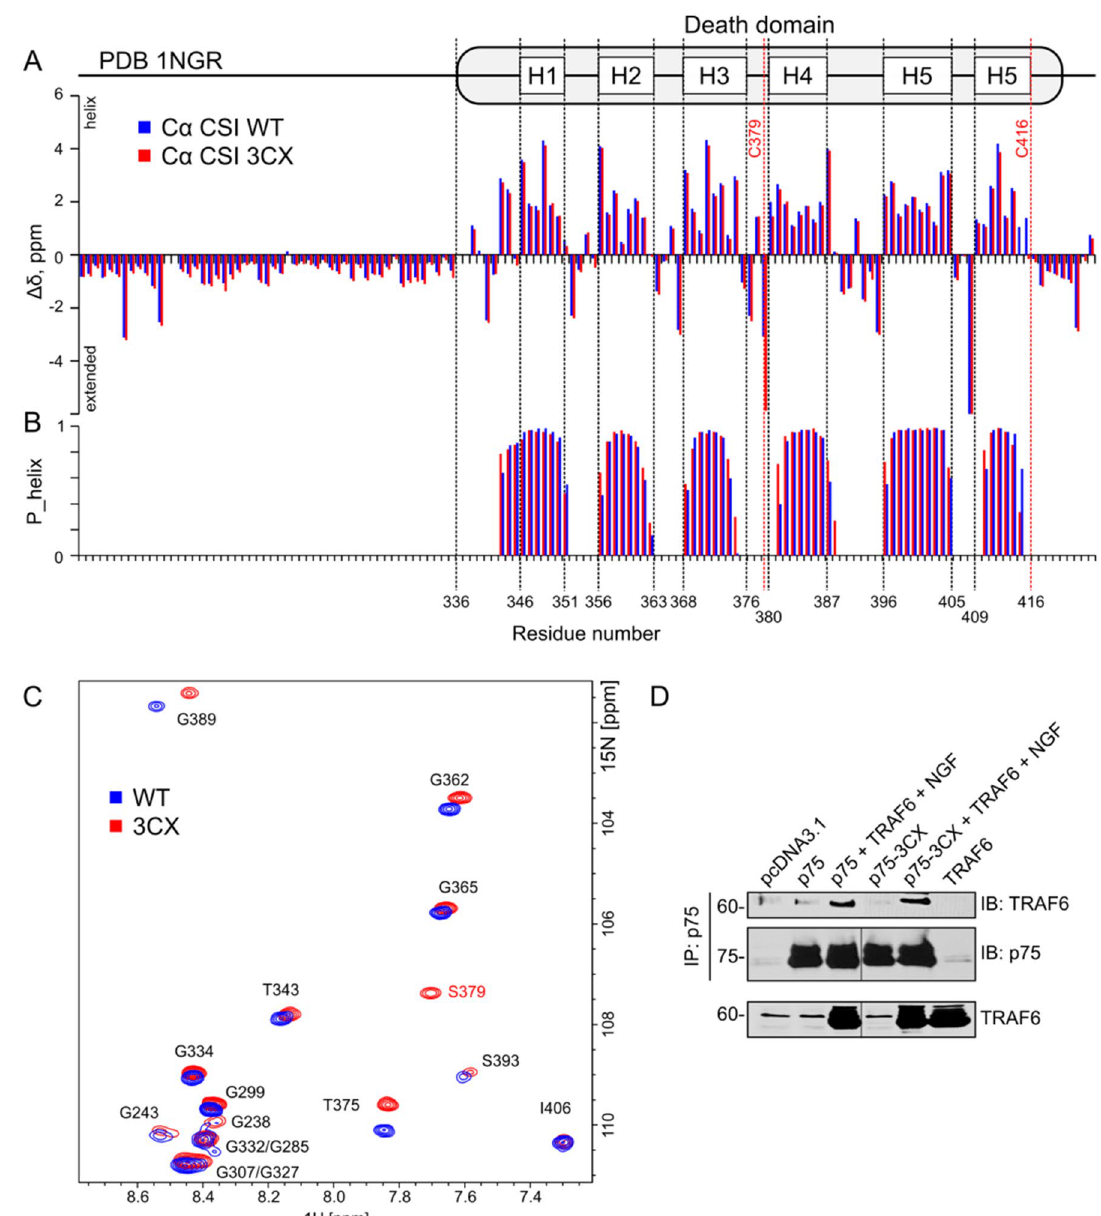
Figure 4. Comparison of structure and activity of wt and 3CX mutant forms of rP75NTR. ( A ) Secondary chemical shifts of C α nuclei of rP75-ΔECD (blue bars) and rP75-ΔECD-3CX (red bars). The secondary structure of the death domain, according to PDB ID 1NGR is shown on top. ( B ) The propensity of ɑ -helical conformation, according to the TALOS-N prediction, based on NMR chemical shifts of rP75-ΔECD (blue bars) and rP75-ΔECD-3CX (red bars). ( C ) Overlay of 1 H, 15 N-TROSY-HSQC spectra (glycine regions) of rP75-ΔECD (blue) and rP75-ΔECD-3CX (red). The assignment is provided in black and red (for the mutated S379 residue). ( D ) Binding of TRAF6 to wild type and mutant rP75-3CX in transfected HEK293 cells. Full-length blots are presented in Supplementary Fig S8. The figure was prepared using the program Inkscape 0.92 (https ://inksc ape.